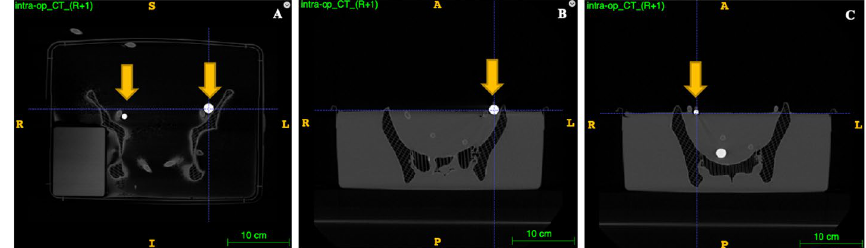
Fig. 3 Computed tomography of the model. Coronal ( A ) and axial CT images showing the target SLNs in both sides (arrows: right SLN ( B ) and left SLN ( C )) in arterial phase. CT, computed tomography; SLN, sentinel lymph